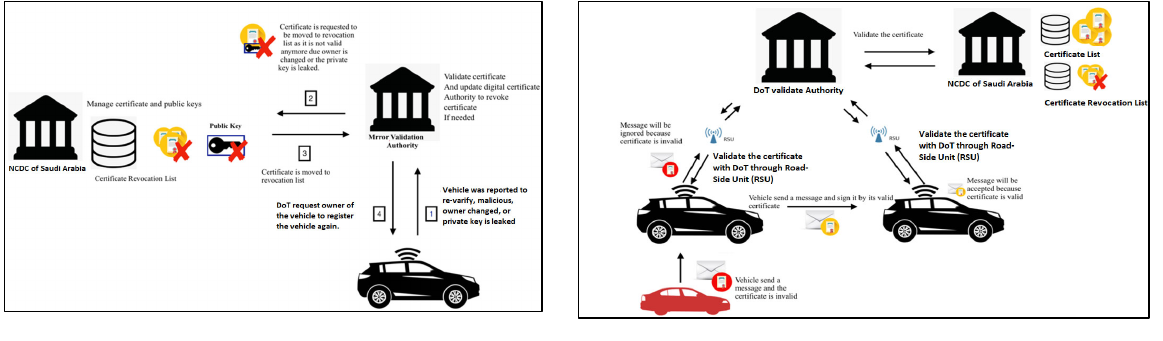
Fig. 4. Certificate Revocation Process Fig. 5. Proposed Trust Model